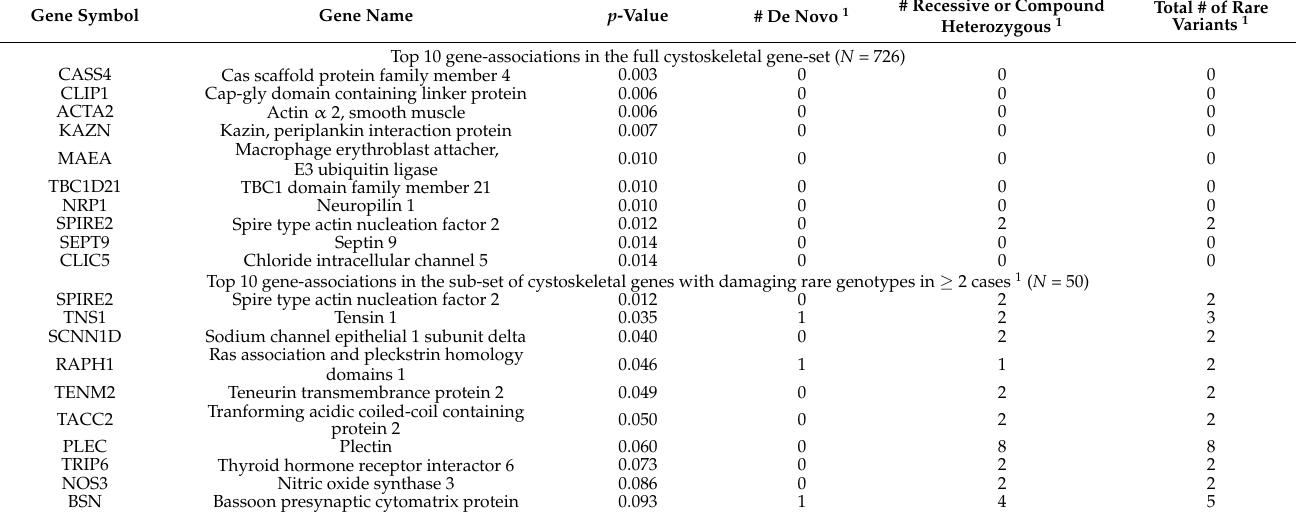
Table 3. Top 10 associations in the analyses of CTDs ( N = 1431 cases) and all genes in the cytoskeleton gene-set and in the sub-set with rare, putatively damaging variants in > 2 cases 1 with a congenital heart defect. Gene Symbol Gene Name p -Value # De Novo 1 Top 10 gene-associations in the full cystoskeletal gene-set ( N = 726) CASS4 Cas scaffold protein family member